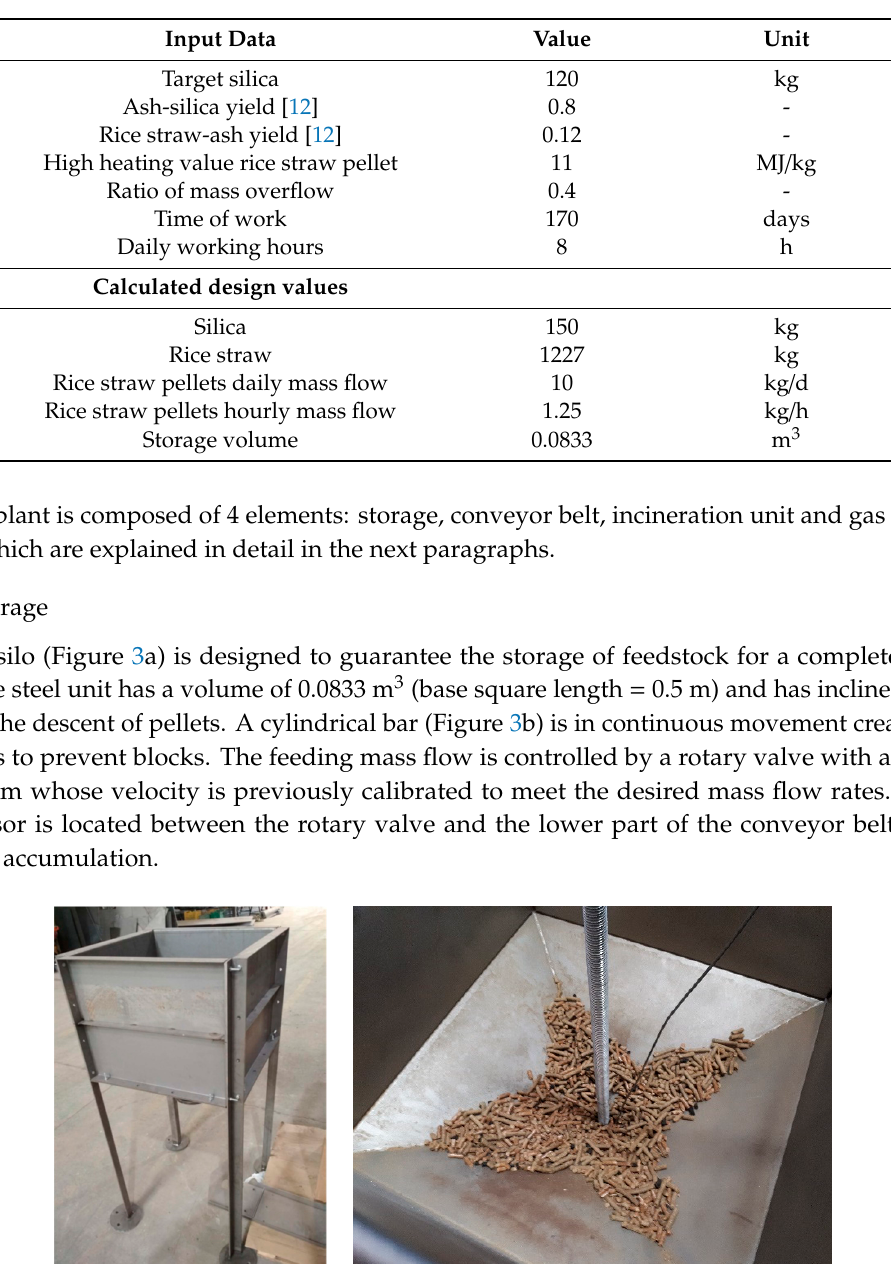
Table 2. Input parameters and initial design calculated variables.